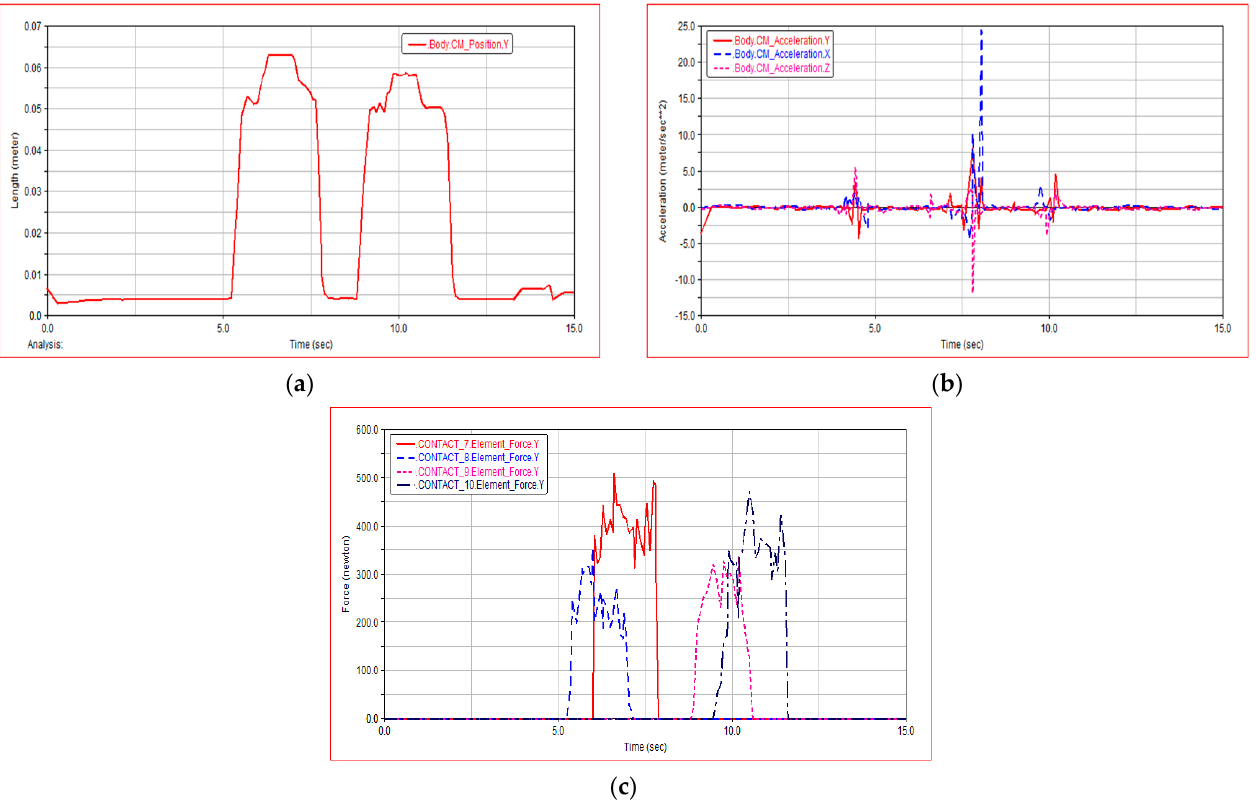
Figure 12. Simulation result of both sides continuously obstacle crossing: ( a ) robot centroid displacement; ( b ) robot centroid acceleration; ( c ) force on the ground contact point of left and right wheels in Y direction.